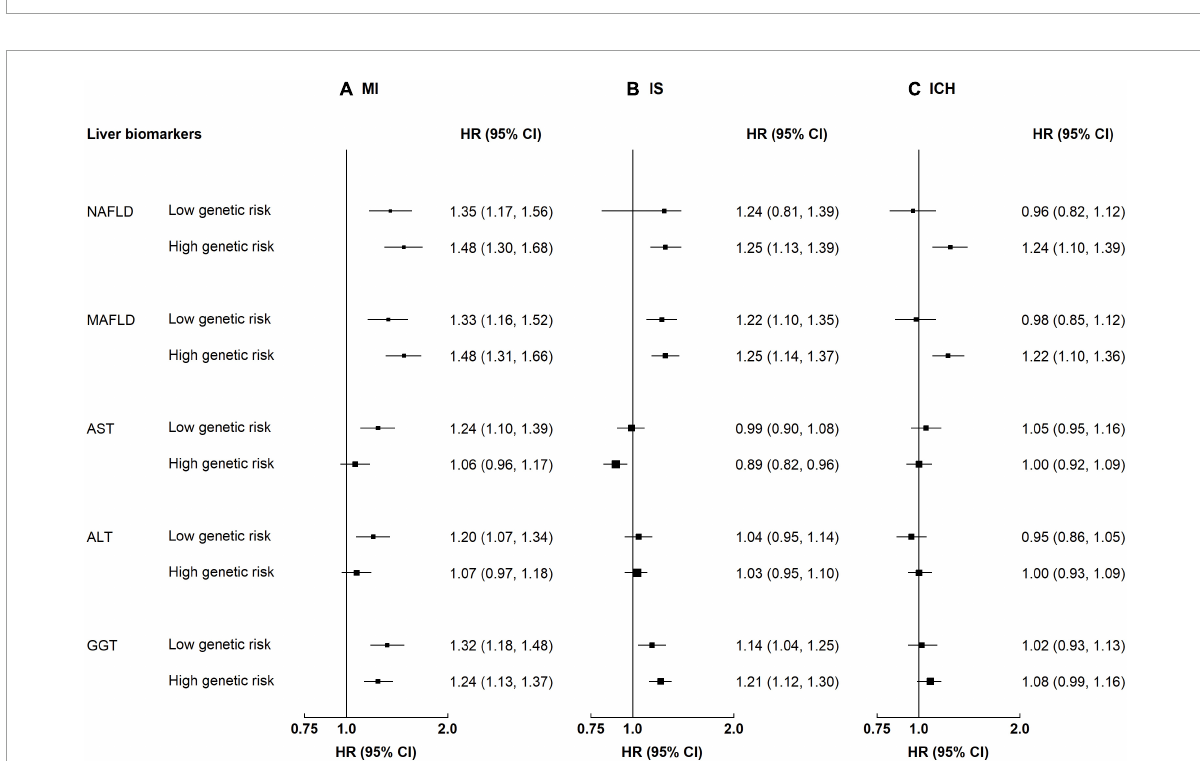
FIGURE3 Associations of liver biomarkers with risk of CVD by genetic predisposition to NAFLD. Columns (A–C) denote the results for MI, IS, and ICH, respectively. Boxes represent the hazard ratios (HRs) of CVD associated with high liver biomarkers, with the size of the box inversely proportional to the variance of the logHR. Liver biomarker was each modeled as a dichotomous variable. The cut-off points are: ≥ median for AST, ALT, and GGT. High genetic risk denotes 1–2 risk increasing alleles of rs73409. Low genetic risk denotes 0 risk increasing alleles of rs73409. The model is adjusted for age, sex, regions, education, smoking, and alcohol. p -Values for interaction: MI 0.11–0.50, IS 0.05–0.81, and ICH 0.009–0.54. p -Values for interaction < 0.05: ICH, FLI 0.009, MAFLD